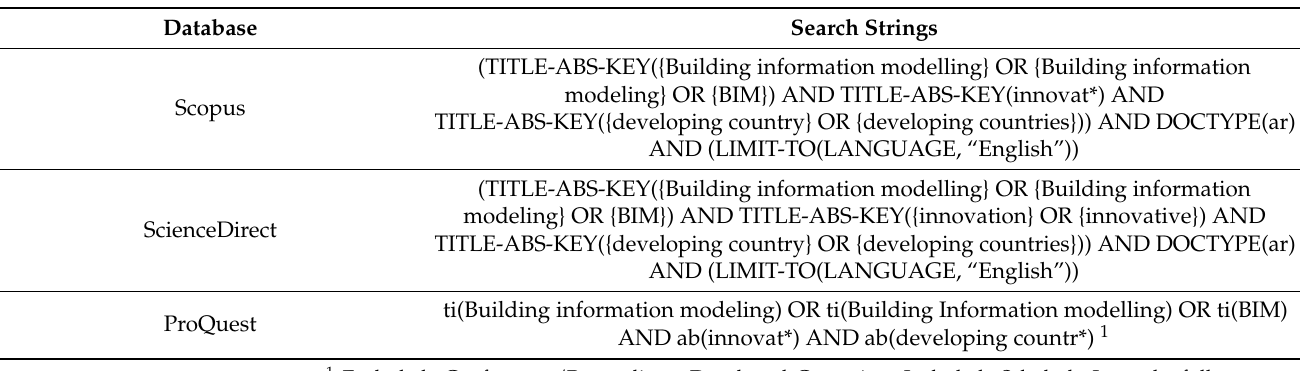
Table 1. Search strings in electronic